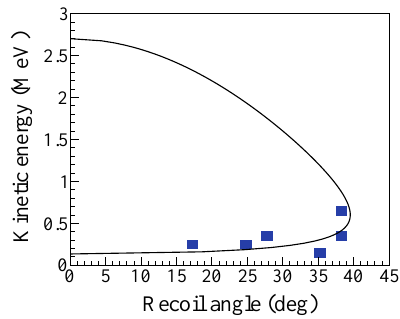
Figure 2. Example of the TPC track of three alpha decay from 12 C event. The left and right panels shows the anode and cathode iamges, re- spectively.